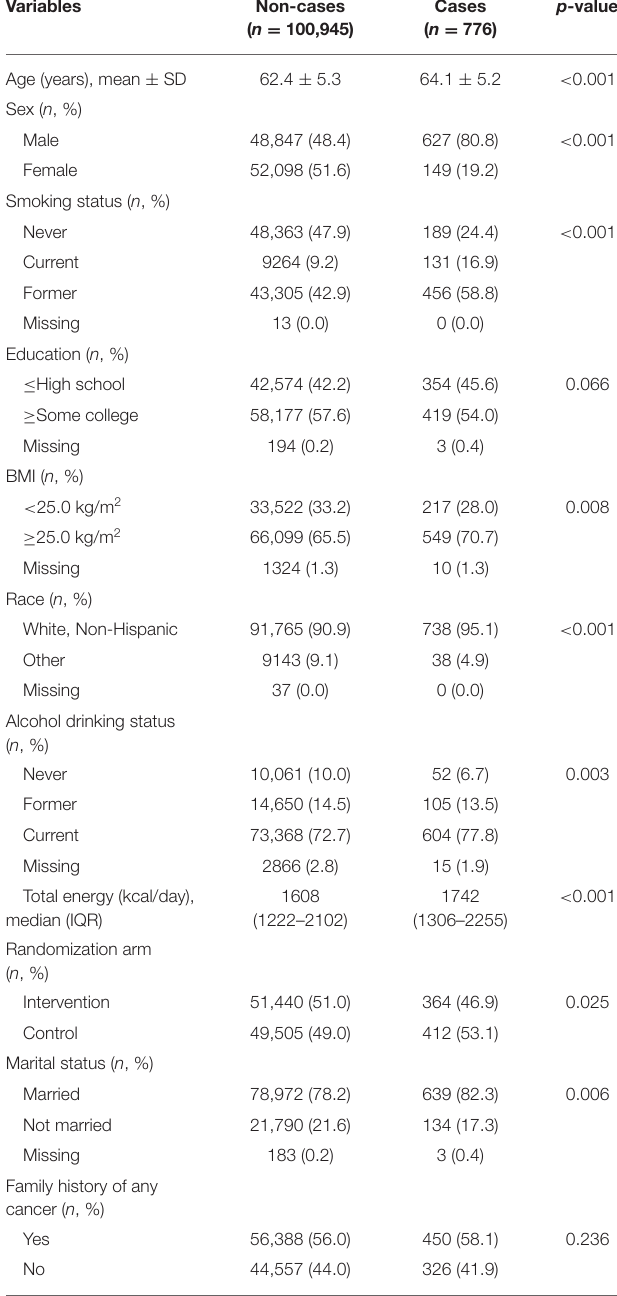
TABLE 1 | Main characteristic of 101,721 subjects in the PLCO cancer screening